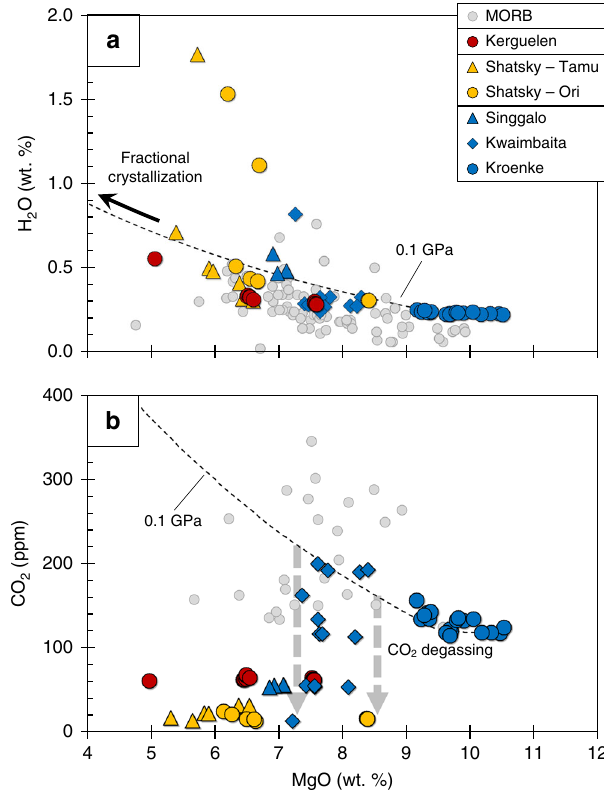
Fig. 3 Cu/Ag and S/Se systematics during crustal differentiation of OPB and MORB. a Cu/Ag and b S/Se versus [MgO] of OPB and MORB. Because the D sulf/sil of Cu and Ag are similar (e.g., ref. 1 ), both OPB and MORB